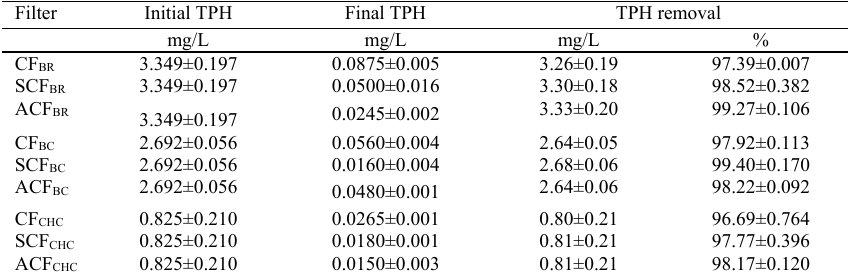
Table 4: Results for filter efficiency